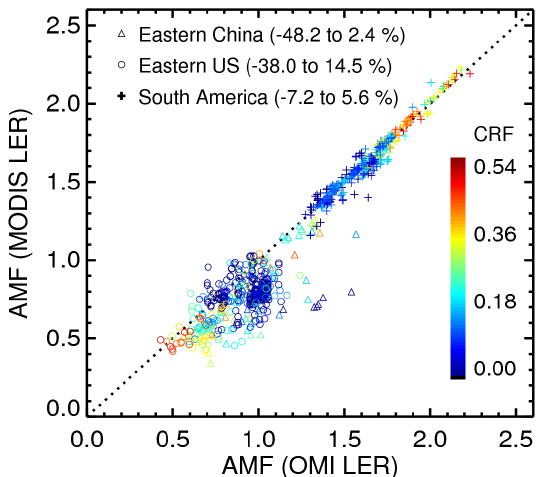
Figure 16. AMFs calculated with geometry-dependent MODIS- based LERs and climatological OMI-based LERs over 5 ◦ × 5 ◦ boxes in eastern China (115–120 ◦ E, 36–41 ◦ N; triangle), eastern US (75–80 ◦ W, 36–41 ◦ N; circle), and South America (55–60 ◦ W, 20–25 ◦ S; plus sign) for clear to moderately cloud skies f r < 0 . 5. Orbit 12414 of 14 November 2006 for data over America and orbit 12391 of 13 November 2006 for data over China. AMF calculated with the MODIS-based LER includes the combined effects of sur- face BRDF and O 2 –O 2 cloud parameters. Symbols are color-coded by f r . Numbers in parentheses represent percent differences at the 2nd and 98th percentile